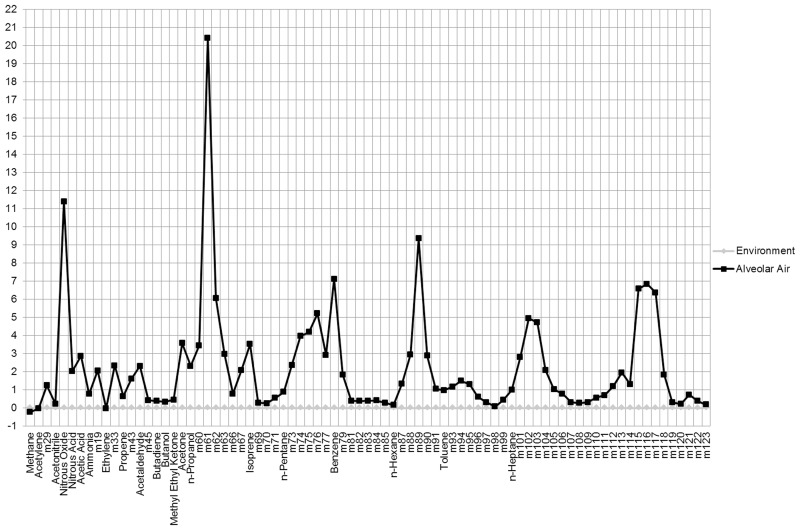
For the 81 molecules considered, difference between median values of alveolar and environmental air, with values standardized to environmental air.